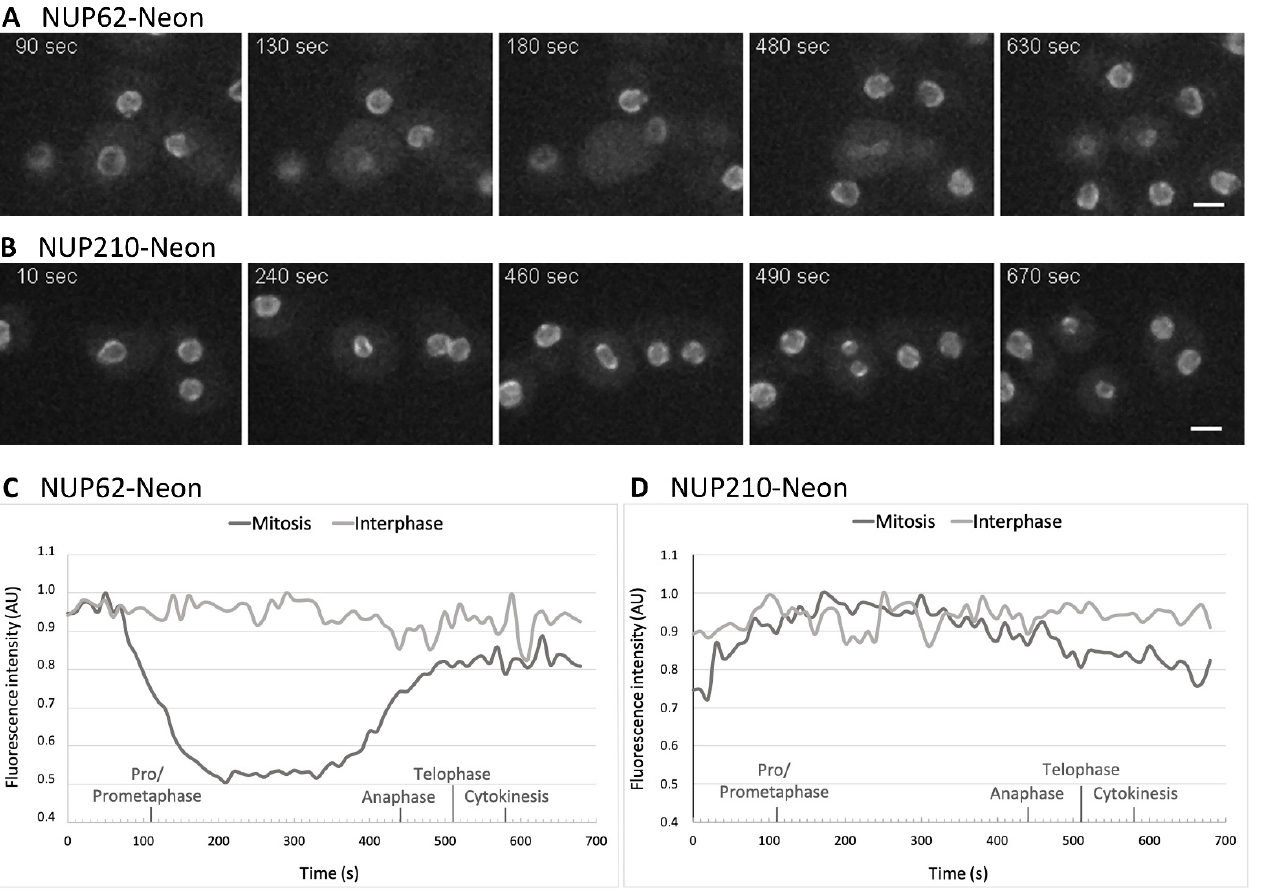
Figure 5. Dynamic changes of the NPCs during mitosis. Live cell spinning disk confocal microscopy of NUP62 neon knock ‐ in cells ( A , C ) and NUP210 neon knock ‐ in cells ( B , D ) with excitation at 488 nm. Selected time points of Video S5 and S6 are shown. ( A ) The central FG NUP62 disappears from mitotic NPCs at the onset of mitosis and reappears right before karyokinesis at time point 10:50 min. ( B ) The transmembrane protein NUP210 remains at the NPC during the en ‐ tire cell cycle. Maximum intensity projections of 7–10 slices per image stack (z ‐ distance 0.21 μ m ( A ) and 0.5 μ m ( B ), re ‐ spectively). Stacks were recorded every 10 s. Bar = 5 μ m. C and D: Intensity of the nuclear neon signal of the of mitotic and interphase cells shown in A and B. Estimated start points of mitotic phases are indicated on the time line (x ‐ axis) based on cell morphology and nuclear shape observed in the fluorescence channel (specific and background signal). Intensity of the NUP signal was measured with Fiji using a summed sliced projection and normalized to the maximal